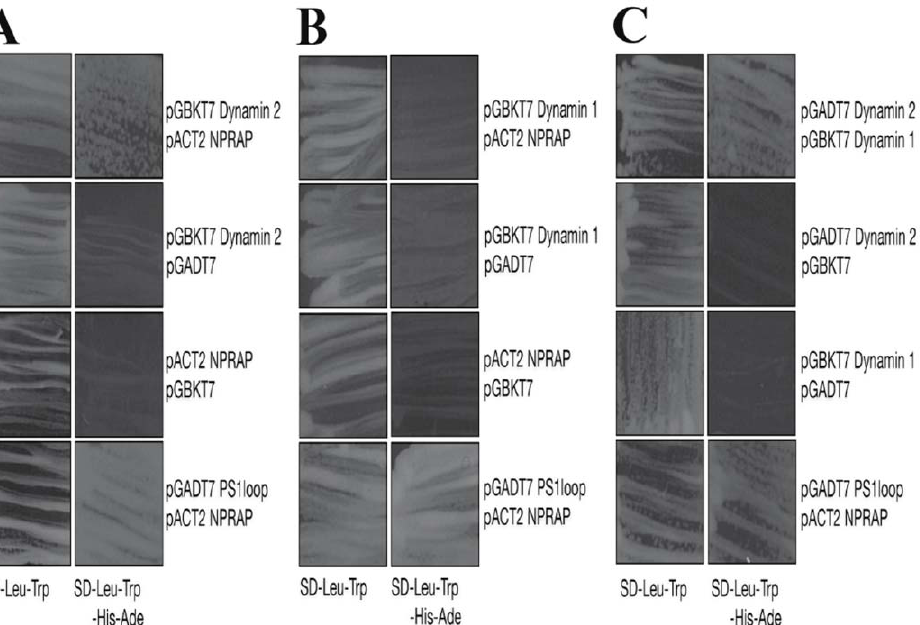
Figure 3. NPRAP binds dynamin 2 directly. Yeast transformants harboring plasmids that encode the hybrid ‘‘bait’’ and ‘‘prey’’ proteins survive in SD-Leu-Trp selective media (left columns). However, the survival in SD-Leu-Trp-His-Ade depends on the ability of the ‘‘prey’’ and ‘‘bait’’ to interact directly. Upon direct interaction, their hybrid activating and binding domains are brought close enough to reconstitute a functional transcription factor, which is needed to trigger the production of the above nutrients (right columns). Dynamin 2 interacted directly with NPRAP (A), whereas dynamin 1 did not (B). Dynamin 1 was functional in the system and interacted with dynamin 2, suggesting an NPRAP-dynamin 1 and 2 complex in the cells (C). Results represent five or more individual assays.